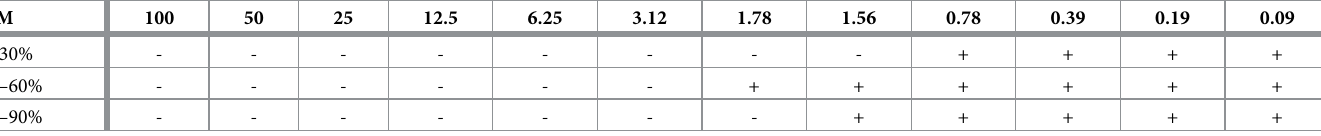
The (+) sign represents haemagglutination and the (-) sign represents no haemagglutination result. Maximum inhibitory concentration for the 30–60% fraction was 3.125